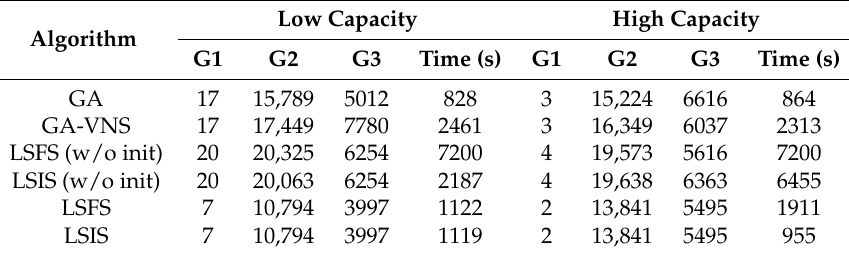
Table 1. Result of Case 1 (low capacity: 2000; high capacity: 4500).